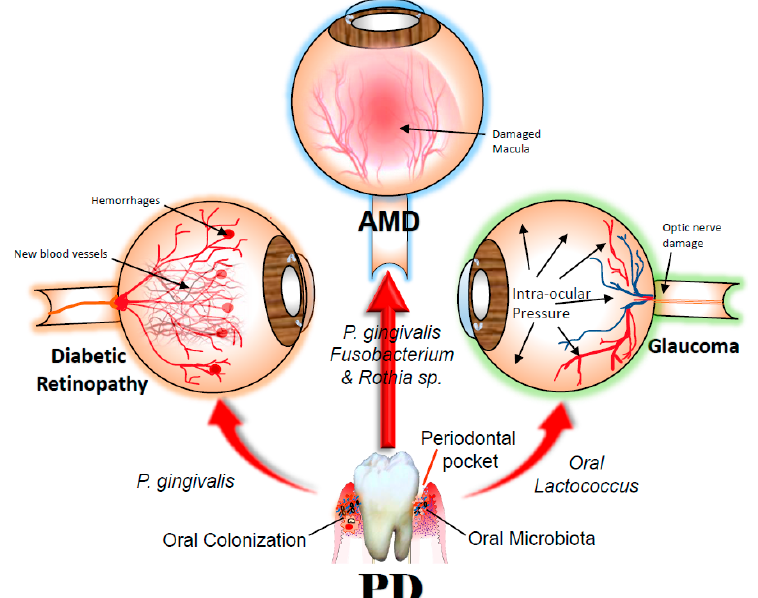
Figure 1. The link between periodontal pathogens and eye diseases. Growing scientific studies show a palpable association between oral pathogens (PD) and eye diseases (AMD, Glaucoma, and Diabetic Retinopathy). A mechanistic explanation for the association between chronic inflammaging diseases such as AMD and PD is an imperative need to derive preventive and therapeutic tar- gets. Arjunan et al. in an in vitro study characterized Porphyromonas gingivalis (Pg) invasion in the human RPE cells and its prolonged survival by autophagy evasion within the RPE cells [70]. An- other in vivo study employing a pioneering AMD + PD murine model demonstrated the role of periodontal infection in the augmentation of AMD phenotype [69]). Fusobacterium and Rothia spe- cies were identified as risk factors in the AMD by Pockpa et al., [72] and Rullo et al., [42], respec- tively. Chiu et al. demonstrated that Pg increases the risk for early diabetic retinopathy [98]), and oral Lactococcus was found to be markedly depleted in glaucoma patients, as shown by Yoon et al. [74] ). AMD—Age-related Macular Degeneration; PD—Periodontal disease.